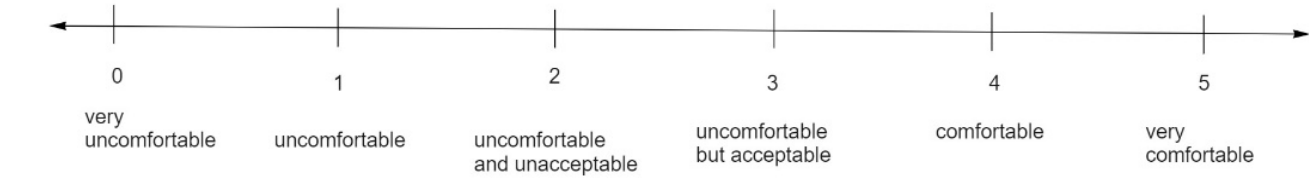
Figure 7. Thermal comfort evaluation index.